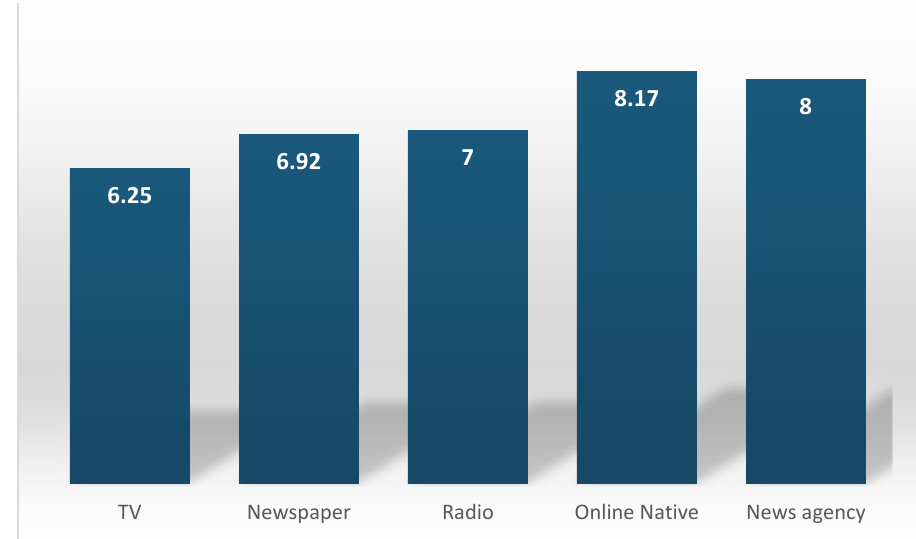
9 Figure 5. How AI can help journalistic work (scale: From 1 to 10).